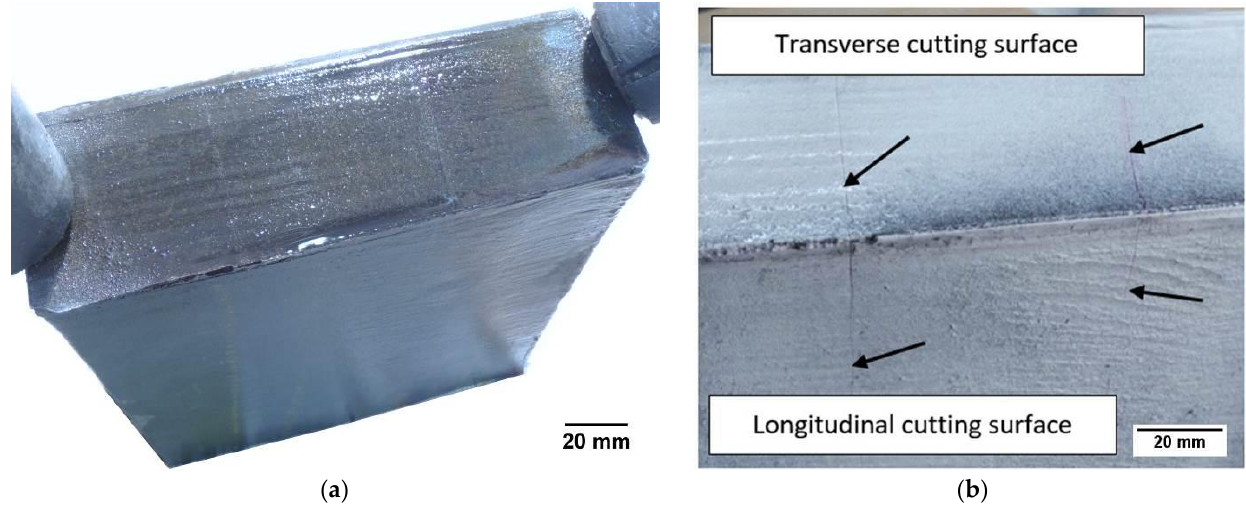
Figure 1. General view of the cut rod after: ( a ) cutting, ( b ) painting with primer paint and magnetic particle test. Table 1. Chemical composition of tested steel (data from the manufacturer inspection certificate